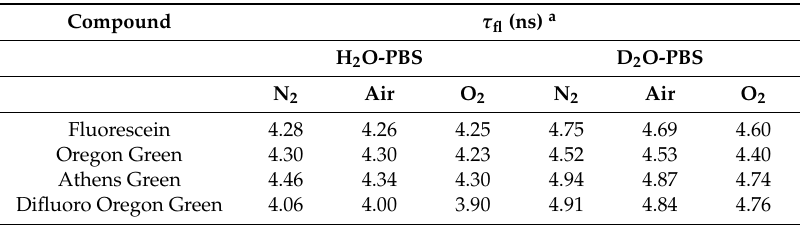
a. Errors on all numbers are ± 0.05